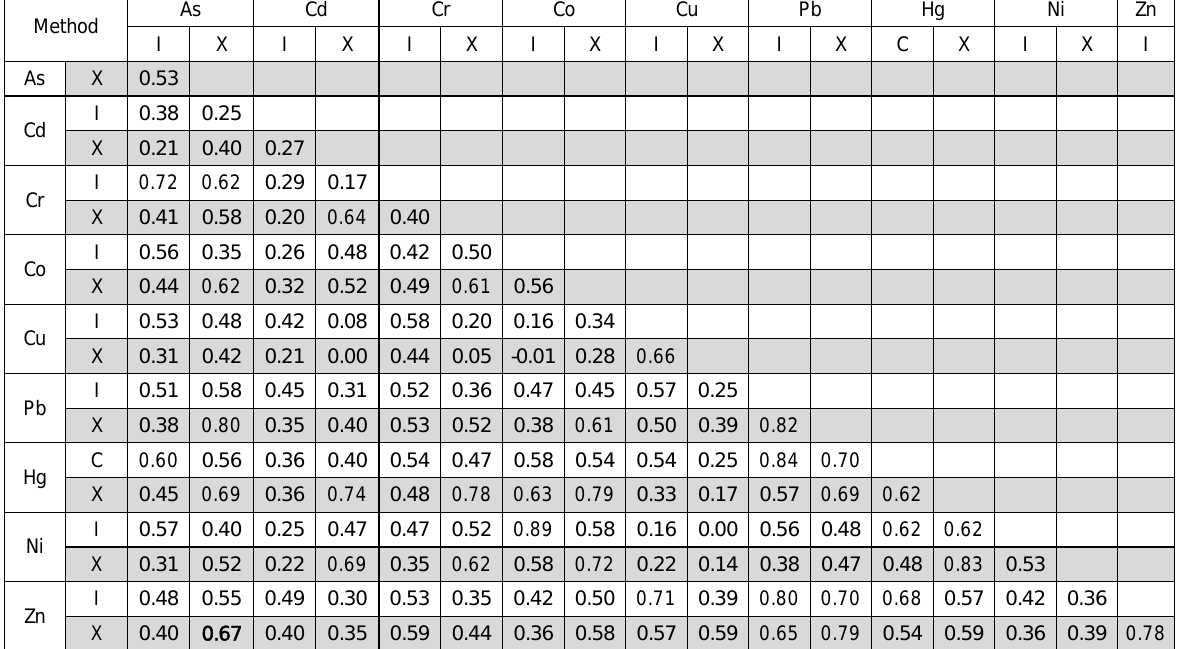
Table 5. Spearman Correlation Coefficient Matrix Comparing Matched Sample Concentrations for Each Metal and Method of Analysis